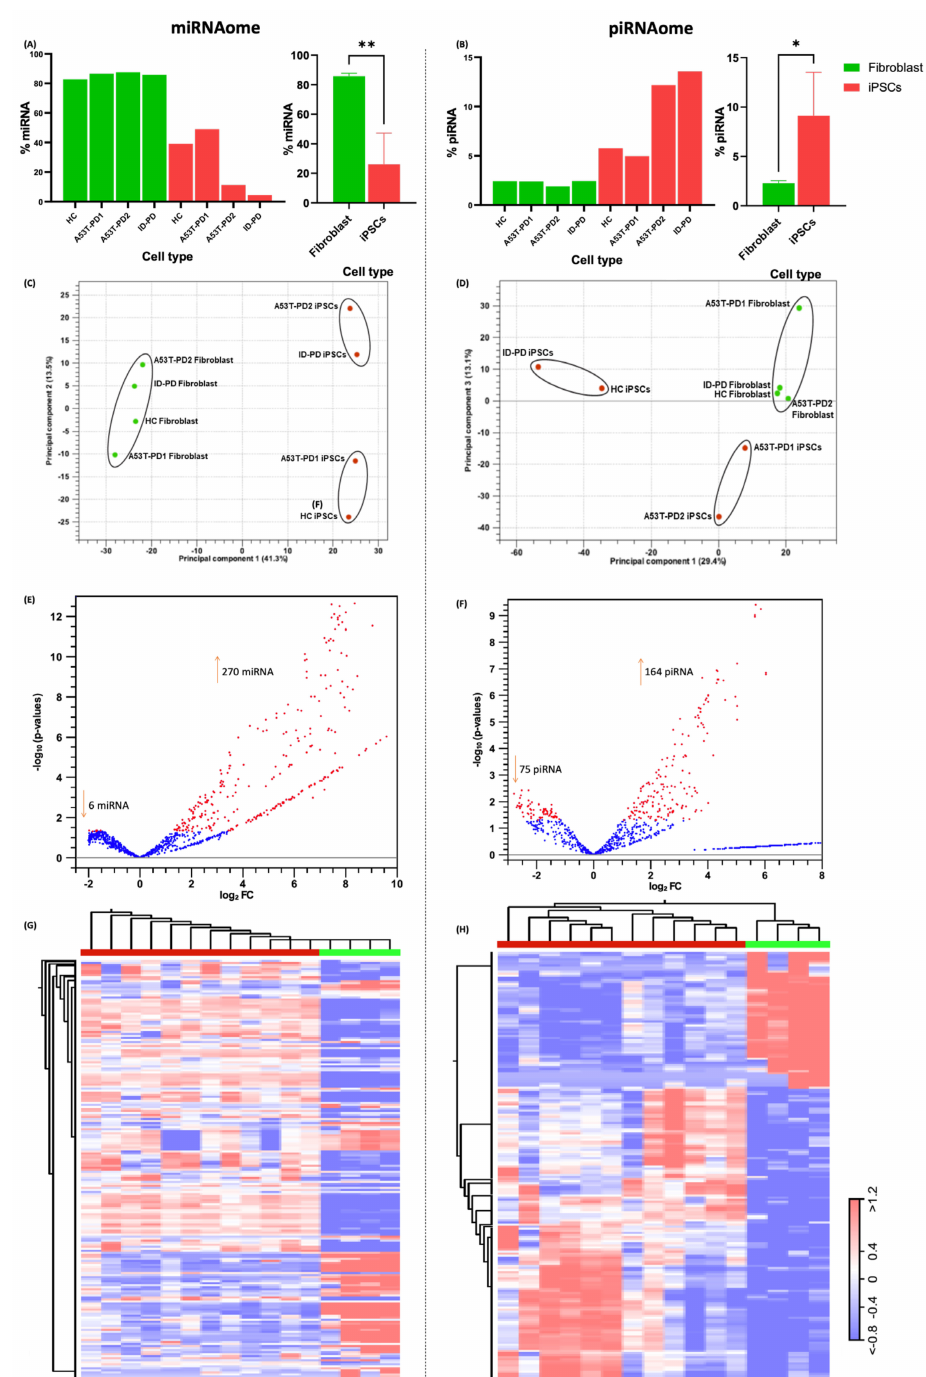
Figure 2. miRNA and piRNA differential expression analysis between fibroblasts and their repro- grammed iPSCs. ( A ) Bar graph showing that all fibroblasts samples express similar percentage of miR- NAs, and it is significantly higher from miRNA expression in their iPSC samples ( p -value = 0.0015; p -value < 0.01 corresponds to **). ( B ) piRNA expression in hiPSCs is significantly higher than their fibroblast samples ( p -Value = 0.0208; p -value < 0.05 corresponds to *). ( C , D ) Principal component analysis (PCA) based on DE miRNAs and piRNA found between fibroblasts and their reprogrammed iPSCs. ( E , F ) Volcano plots of total DE miRNAs and piRNA found between fibroblasts and their reprogrammed iPSCs, respectively. ( H ) heat map of DE miRNAs in fibroblasts vs. iPSCs. ( G ) heat map of DE piRNAs in fibroblasts vs.